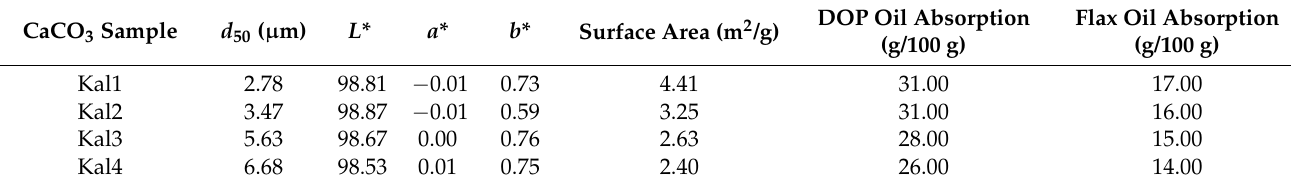
Table 2. Properties of CaCO 3 powders used in this